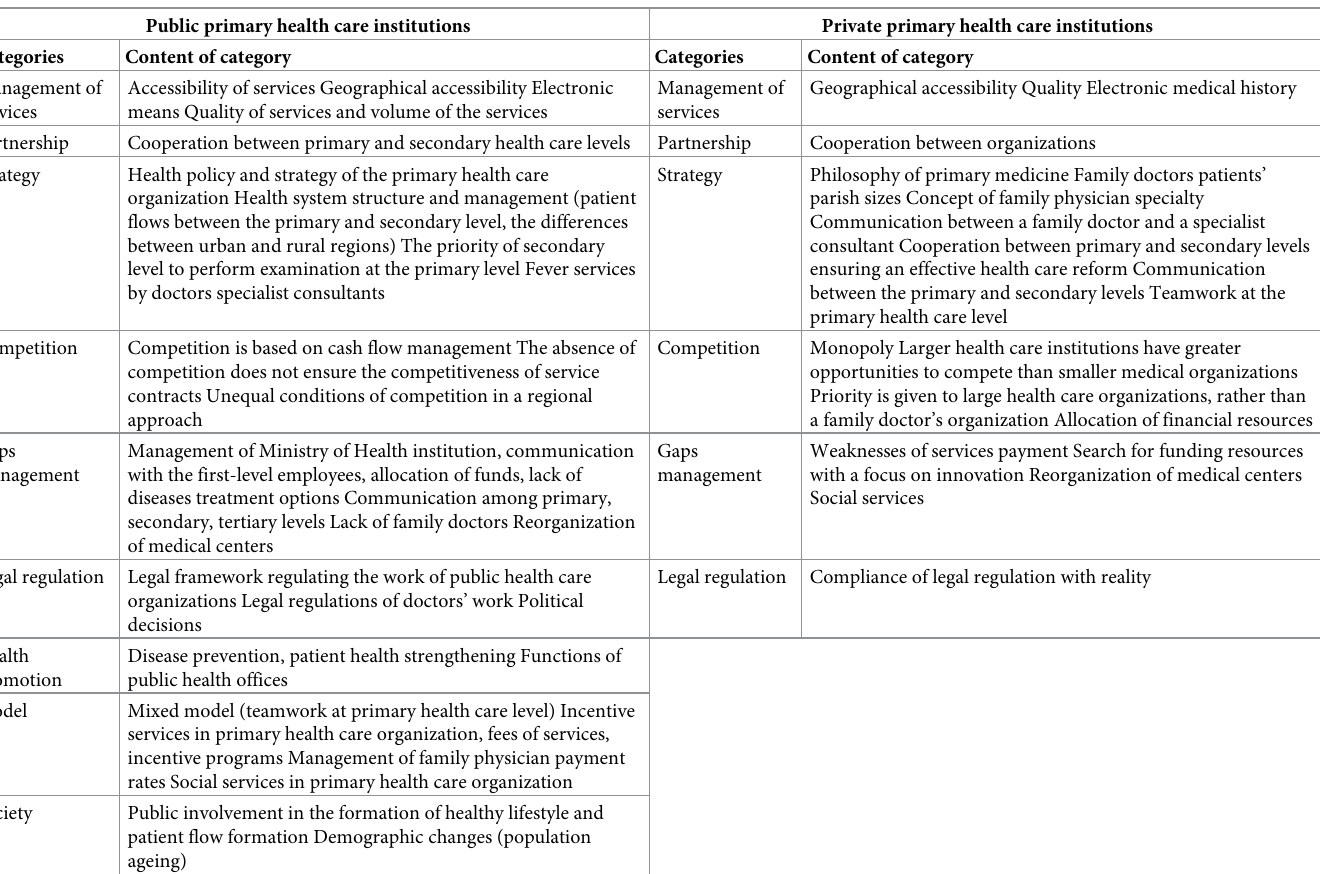
Table 5. Categories of “health policy decision making”